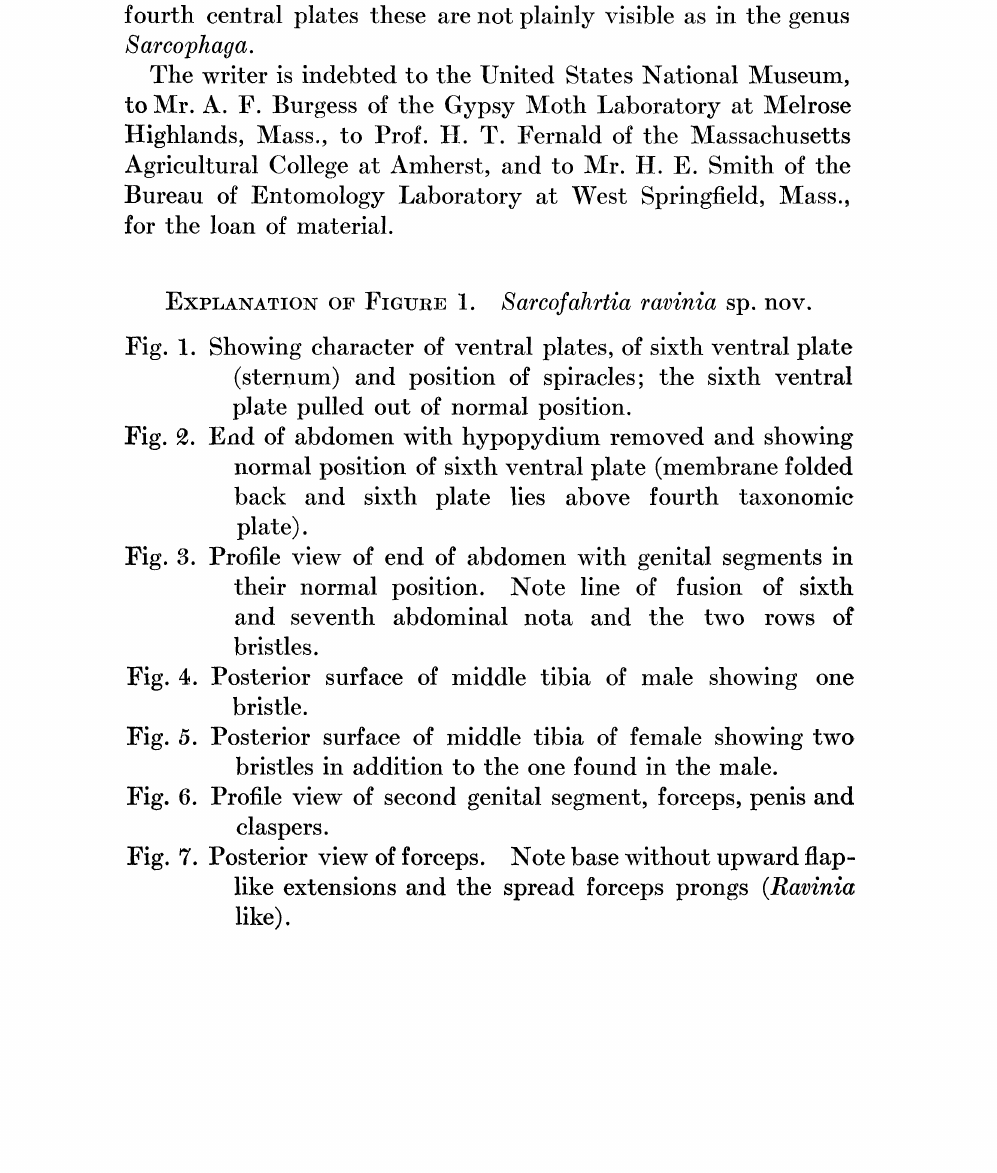
Fig. 1. Showing character of ventral plates, of sixth ventral plate . (sternum) and position of spiracles; the sixth ventral plate pulled out of normal position. Fig. End of abdomen with hypopydium removed and showing normal position of sixth ventral plate (membrane folded back and sixth plate lies above fourth taxonomic plate). Fig. 3. Profile view of end of abdomen with genital segments in their normal position. Note line of fusion of sixth and seventh abdominal nora and the two rows of bristles. Fig. 4. Posterior surface of middle tibia of male showing one bristle. Fig. 5. Posterior surface of middle tibia of female showing two. bristles in addition to the one found in the male. Fig. 6. Profile view of second genital segment, forceps, penis and elaspers. Fig. 7. Posterior view of forceps. Note base without upward flap- like extensions and the spread forceps prongs (Ravinia